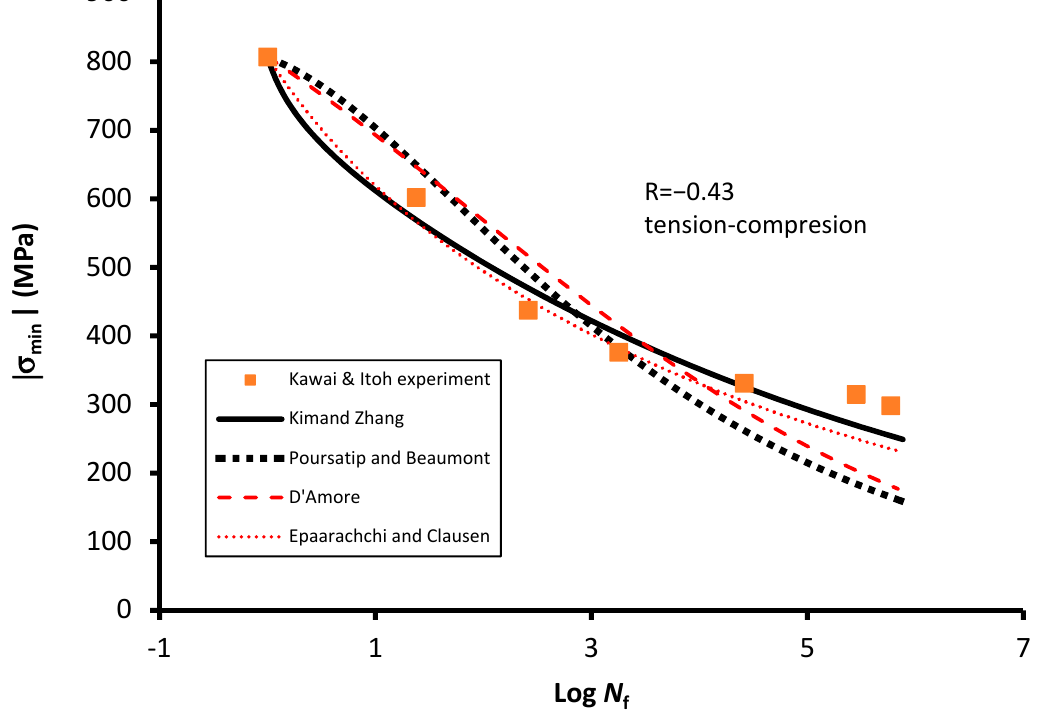
Figure 12. Kawai and Itoh experiment at R = − 0.43 [22] with σ uC = 807 MPa and σ uT = 1887 MPa, and S-N curves obtained from: Kim and Zhang model with α = 8.18 × 10 − 41 , β = 13.6, and N 0 = 1; Poursatip and Beaumont model α = 29 and added N 0 = 1; D’Amore model with α′ = 0.3 and β = 0.19; and Epaarachchi and Clausen model with α′ = 0.0169 and β = 0.14. An experimental data point for N f = 0.5cycle was adjusted to have the initial condition N f = 1 at σ uC for comparison purposes.